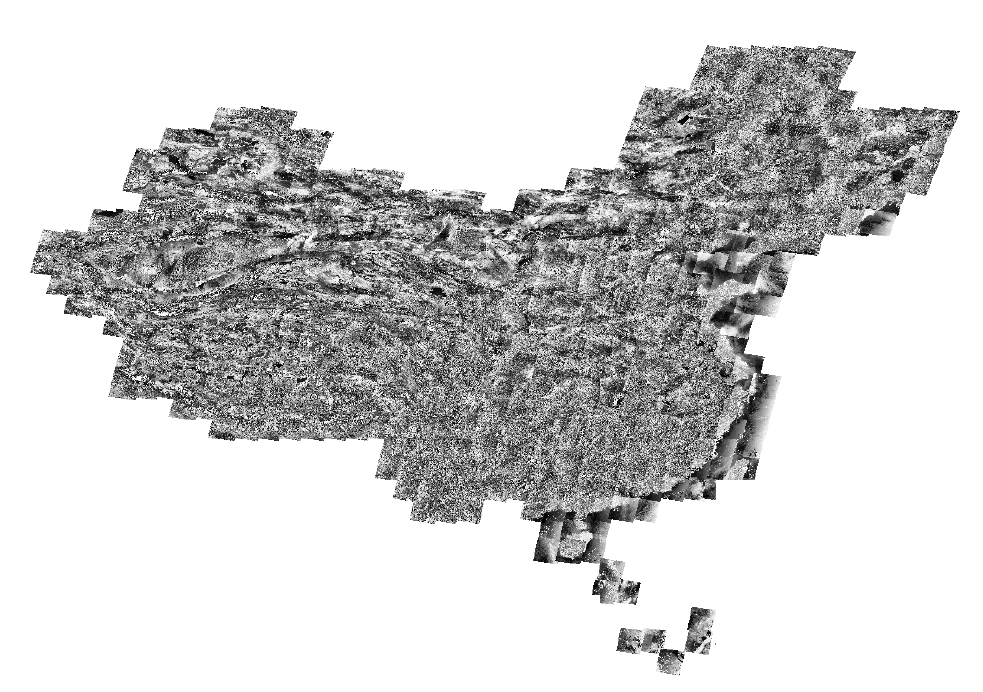
Figure 10. The mosaic result covering entire area of China using Landsat-5 and Landsat-7 satellite im-